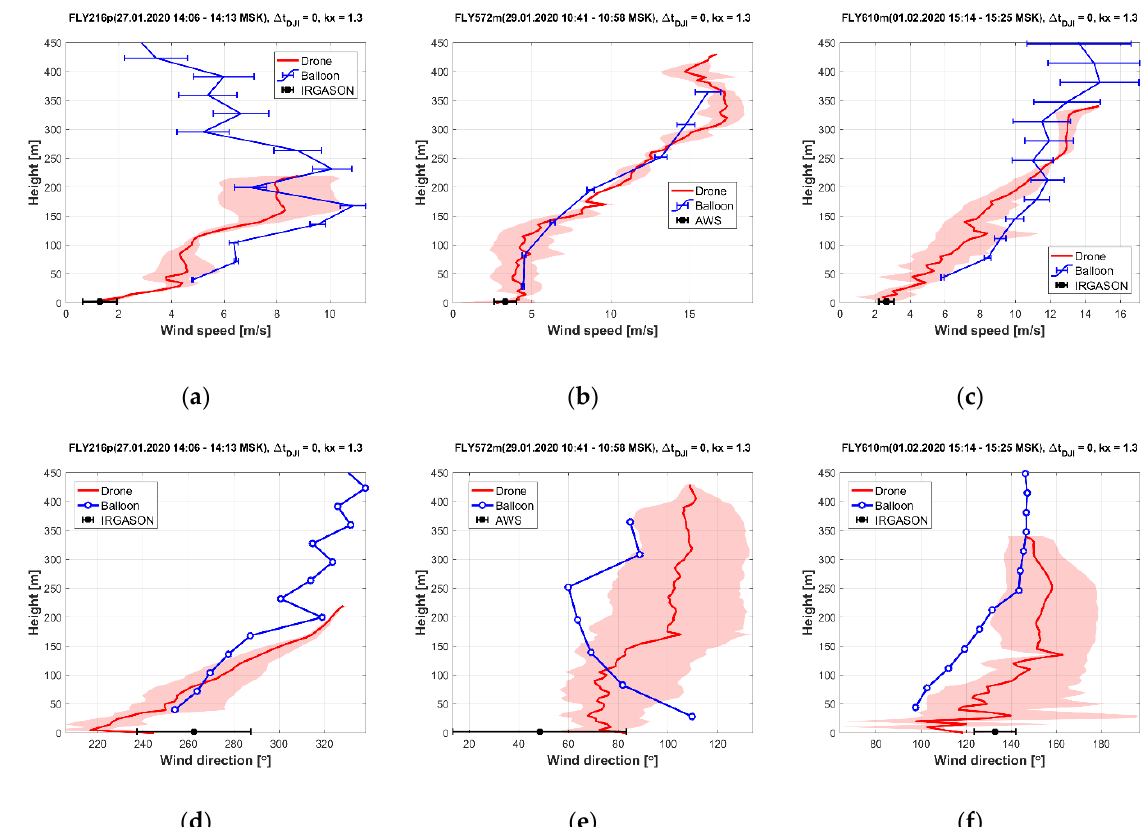
Figure 5. Examples of comparison between balloon and drone soundings for wind speed ( a – c ) and direction ( d – f ) profiles for three cases. For the drone-based profiles, red shading indicates the spread between ascending and descending segments of flight. For balloon-based wind speed profiles, error bars indicate uncertainty as described in Section 2.2. For ground-based observations (IRGASON anemometer or Vaisala AWS if the first is not available), error bars indicate the standard deviation of the wind speed/direction during the drone flight.